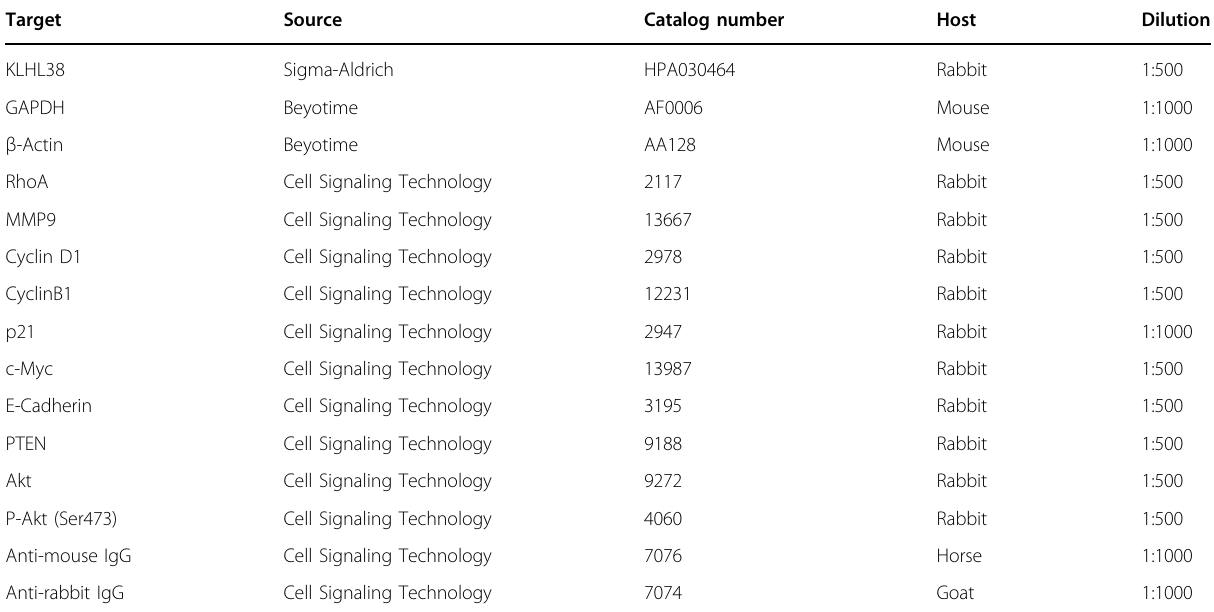
Table 1 List of antibodies used for western blotting.